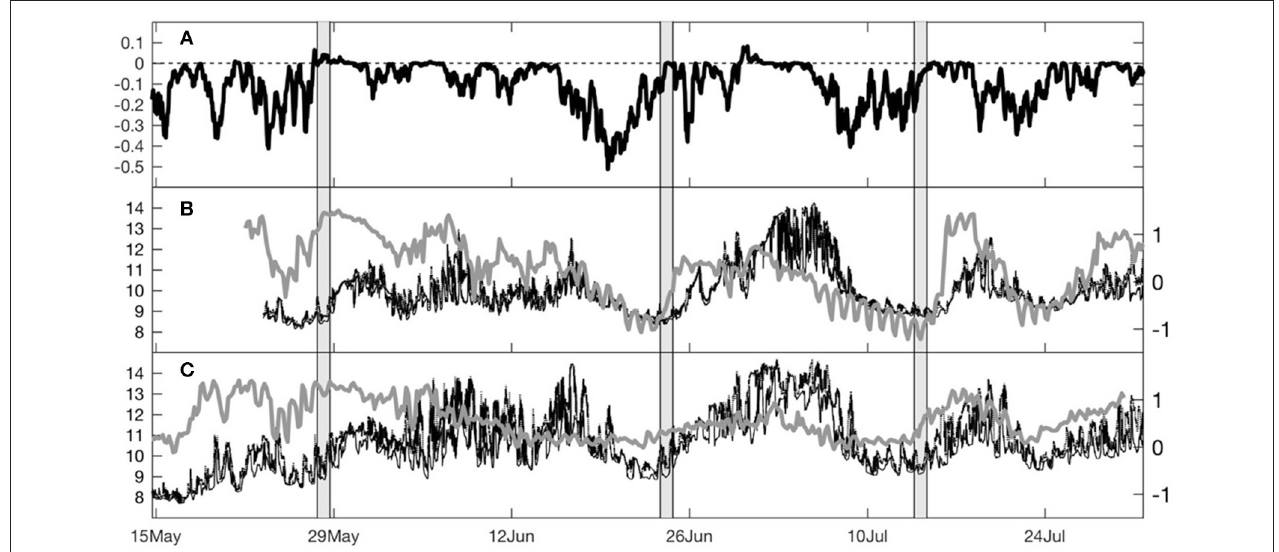
FIGURE 2 | Time series data from 15 May through 26 July 2009: (A) alongshore wind stress at NDBC buoy 46013, (B) Bodega Head temperature and chlorophyll-a fluorescence and (C) Stewarts Point temperature and chlorophyll-a fluorescence. Surface temperature shown as black line and bottom temperature as thin gray line, with chlorophyll-a fluorescence as thick gray line. Survey timing is indicated by vertical gray bars.